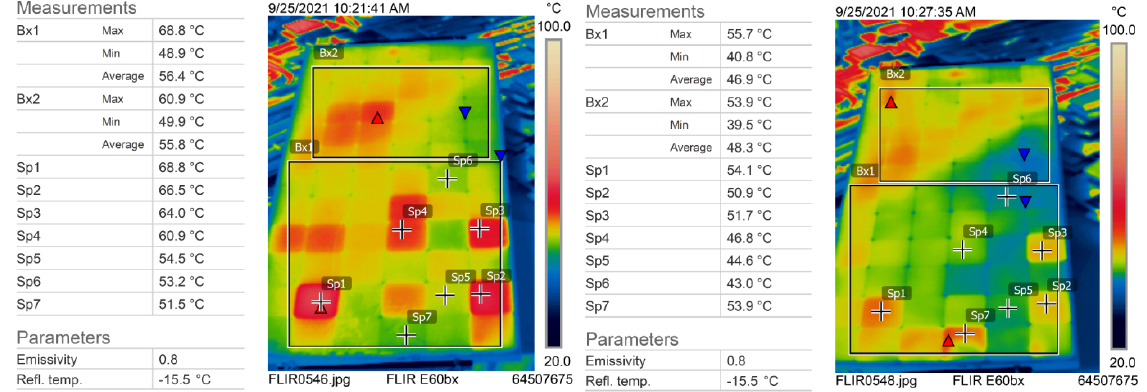
Figure 17. Thermographic analysis of the PV module 1 before and after washing.